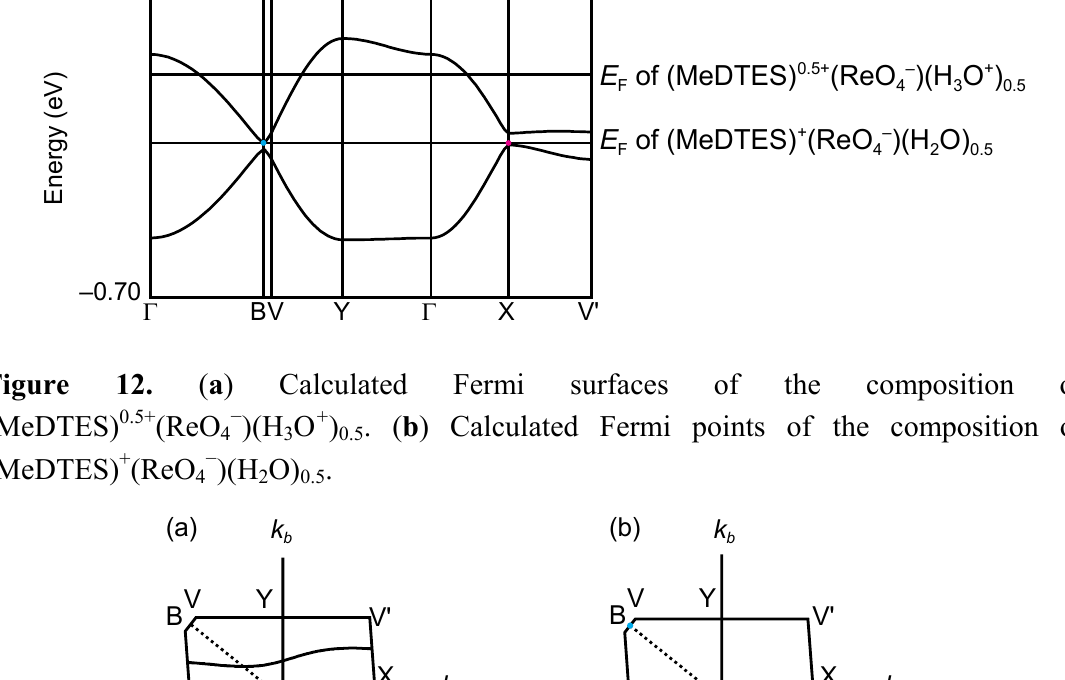
Figure 11. Calculated band dispersion of the salt 5 . The E X–0.700.70